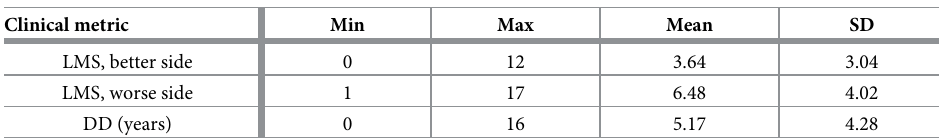
Table 2. Distributions of the clinical metrics for all PD subjects.